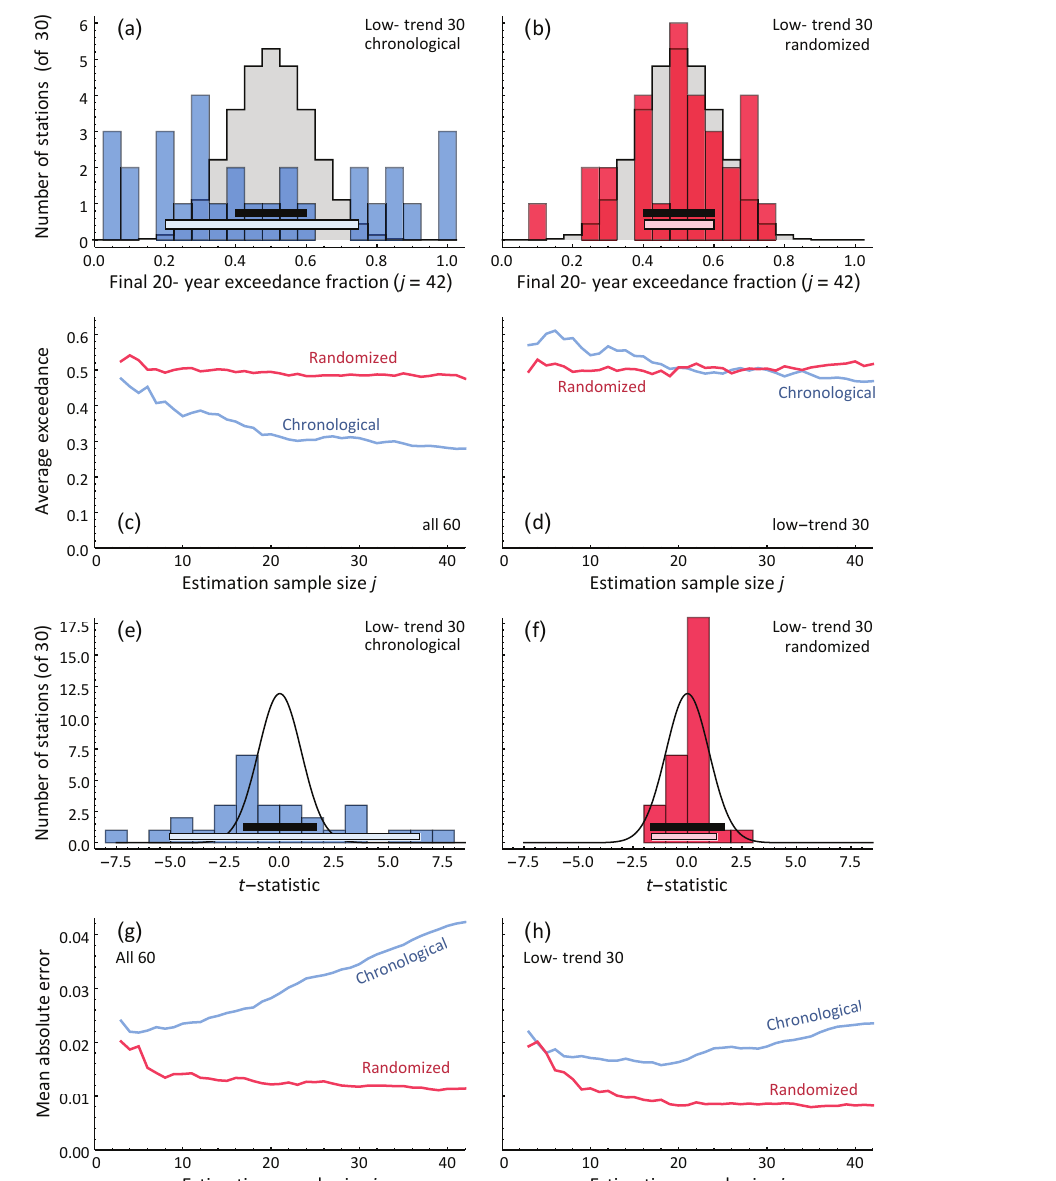
Figure 6. P50 estimator performance. (a) , (b) Distribution of fractions of each of the 30 low-trend station’s final 20 years with c.f. exceeding estimated P50 ( ˆ µ 42 ,(cid:96) ) for actual and randomized data, with expected binomial distribution (gray); horizontal bars extend across the central two quartiles (binomial: black bar; data: light bars). (c) , (d) P50 bias for all 60 stations, and for the 30 stations with low average trend. (e) , (f) Distribution of t statistic, theoretical pdf (curve), and 90% confidence intervals (theoretical: black bar; data: light bars) for difference between ˆ µ 42 and ˆ M for actual and randomized data, respectively, of 30 low-average-trend stations. (g) , (h) P50 estimate MAE for all 60 stations and for 30 stations with low average